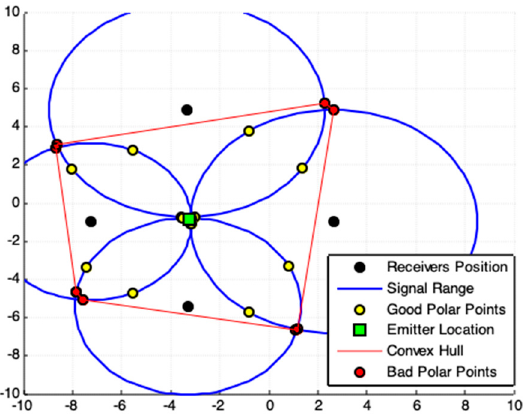
( b ) Figure 7. Different cases and respective responses of the PPC and CHC models. ( a ) Five receivers system. The data has some discrepancies. ( b ) Four receivers system. The data has small inconsistencies. For both cases, is better applying the solution provided by Section 2.1. 2.4. Polar Lines Intersections Model (PLI) The polar-line 𝑝 is a line that passes through two corresponding polar-points 𝑃(cid:4666)𝑥 (cid:2869) , 𝑦 (cid:2869) (cid:4667) ∗ and 𝑄(cid:4666)𝑥 (cid:2870) , 𝑦 (cid:2870) (cid:4667) ∗ that belongs to a line of a conic section (circle in this case). These polar-points are obtained by a given pole-point 𝐸(cid:4666)𝑥 (cid:3032) , 𝑦 (cid:3032) (cid:4667) (Figure 1b). The PLI model (Algorithm 3) consists finding all combinations of pole-polar lines using as pole-points the position of each receiver at a time. After, we must compute the points of intersection among all these lines. Figure 8a represents cases of data underestimation provide by sensors. Figure 8b shows a good case for real application. The emitter location should be on the common intersection point among the receiver range circles. Figure 8c shows the exact result. Reliable data quality improves accuracy.